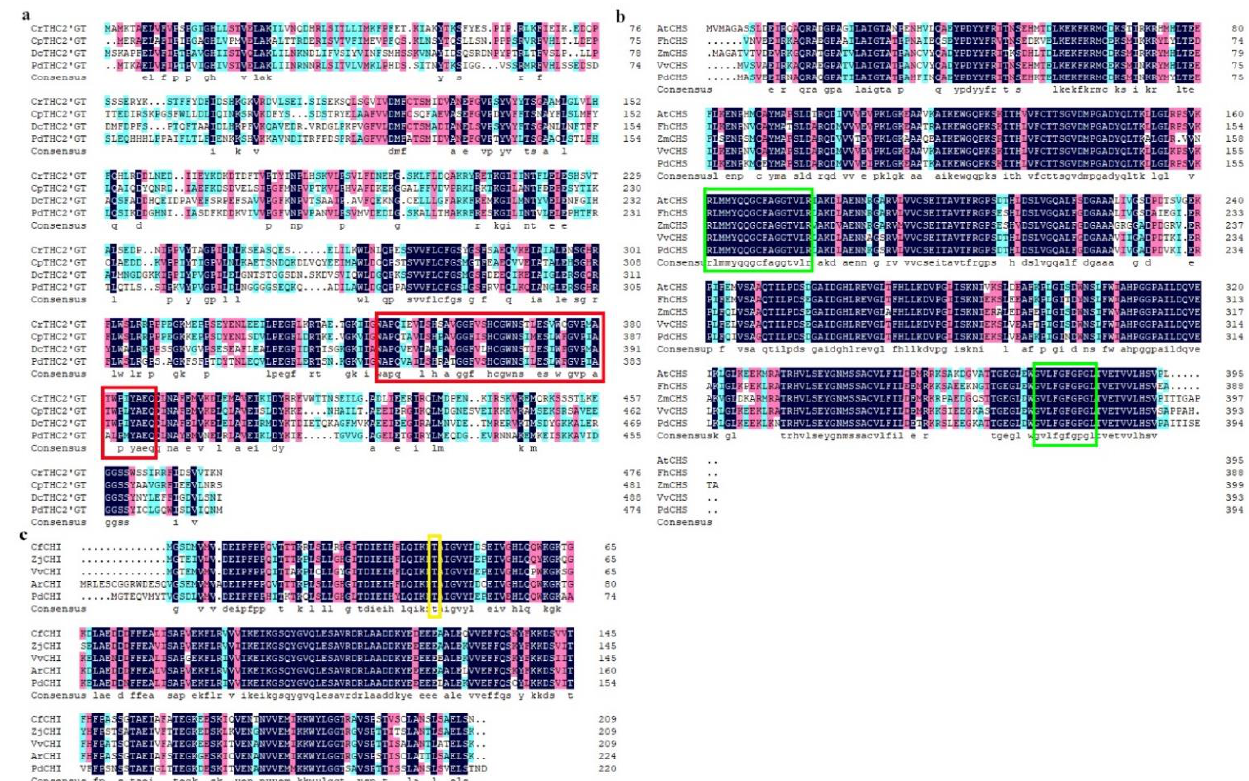
Figure 2. Sequence alignment of THC2 (cid:48) GT , CHS , and CHI from P. delavayi var. lutea and other species. ( a ) Amino acid sequences’ homologous analysis of the THC2 (cid:48) GT gene and other species’ related genes. The red box shows the glycosyltransferase domains—PSPG-box. ( b ) Amino acid sequences’ homologous analysis of the CHS gene and other species’ related genes. The green box indicates the highly conserved domains of CHS . ( c ) Amino acid sequences’ homologous analysis of the CHI gene and other species’ related genes. The yellow box indicates the conserved active sites of CHI.